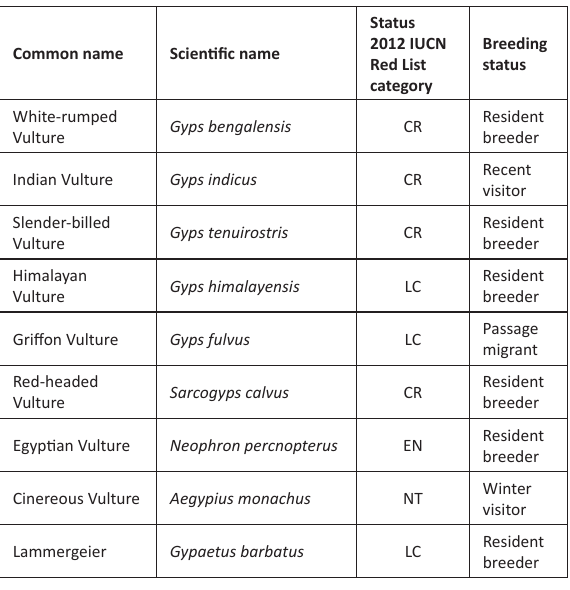
CR - Critically Endangered; EN - Endangered; NT -Near Threatened; LC - Least